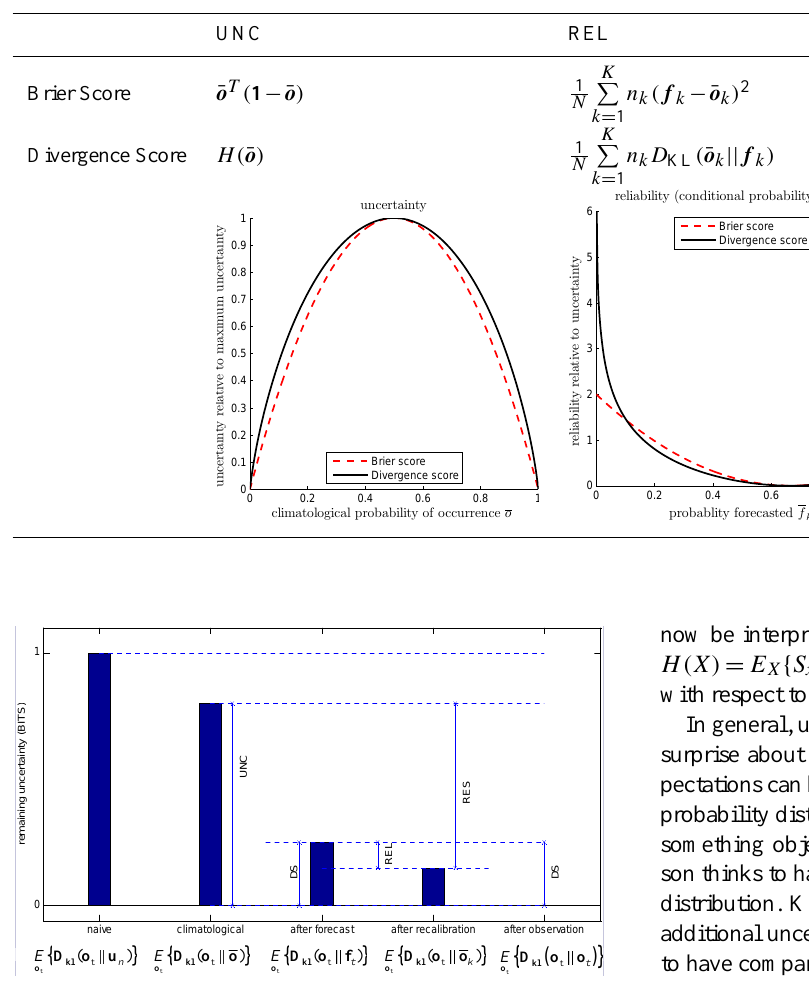
Fig.1. TheremaininguncertaintyfordifferentdistributionsintheforecastingprocesscanbemeasuredbytheaverageKullback-Leibler divergencefromtheobservations.Theseuncertaintieshavesomeadditiverelations( DS=UNC − RES+REL ). Fig. 1. The remaining uncertainty for different distributions in the forecasting process can be measured by the average Kullback- Leibler divergence from the observations. These uncertainties have some additive relations (DS = UNC − RES +